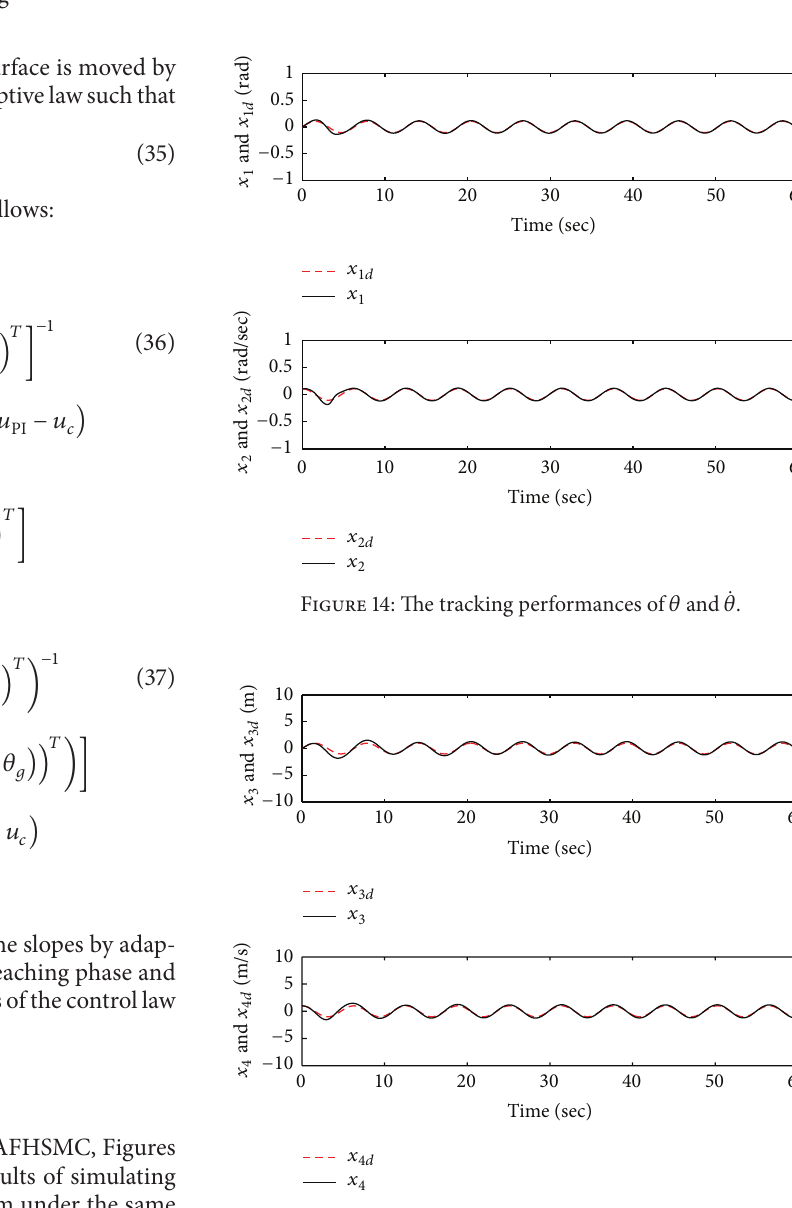
Figure 15: The tracking performances of 𝑥 and ̇𝑥